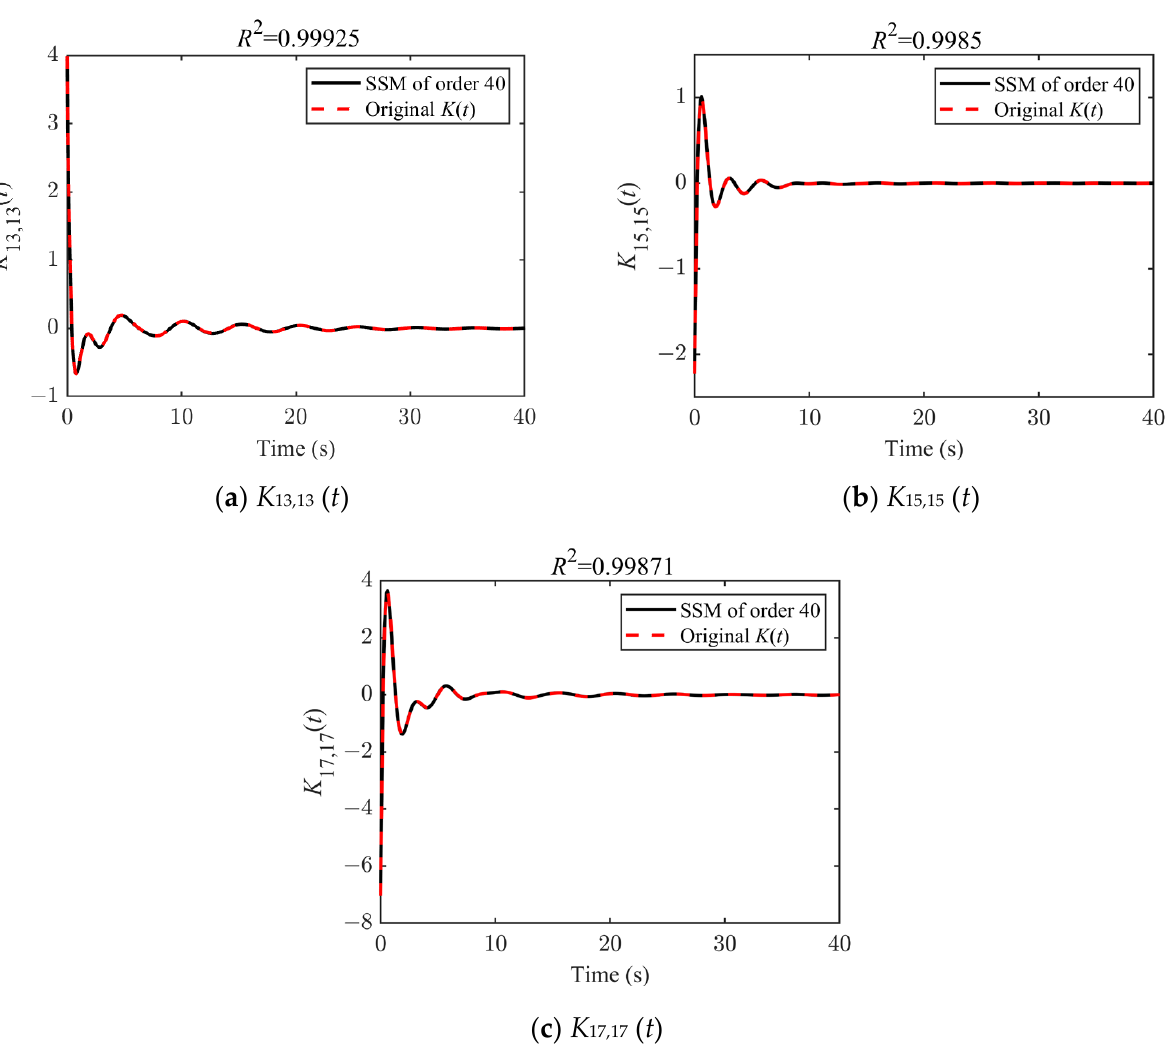
Figure 11. Fitting quality of the MDOF SSM for K( t ) based on the frequency-domain results with damping lid factor α = 0 .1.